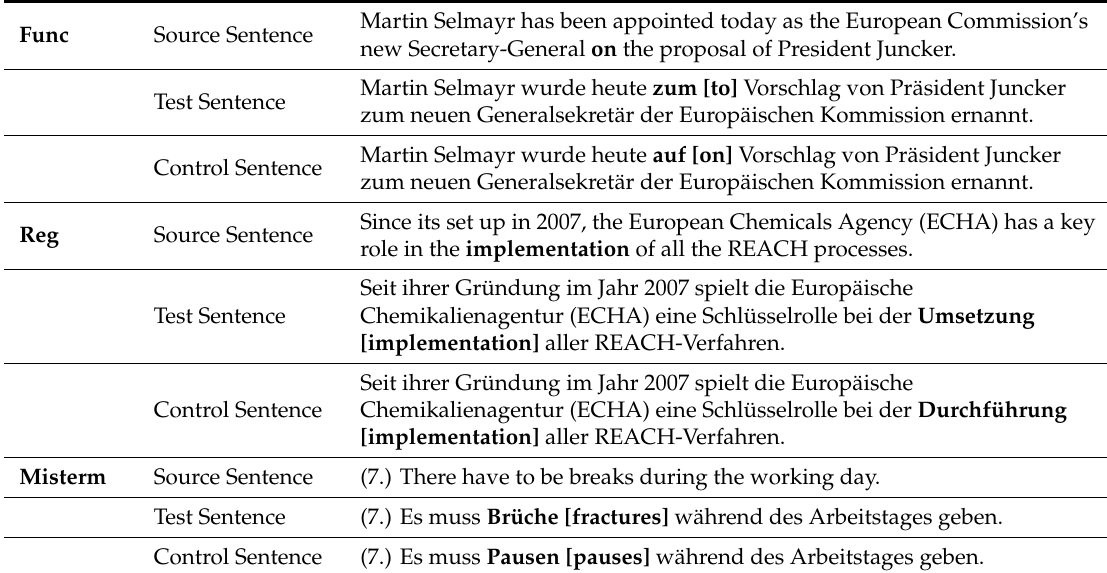
Table 3. Example sentences for the stimuli structure in the eye-tracking